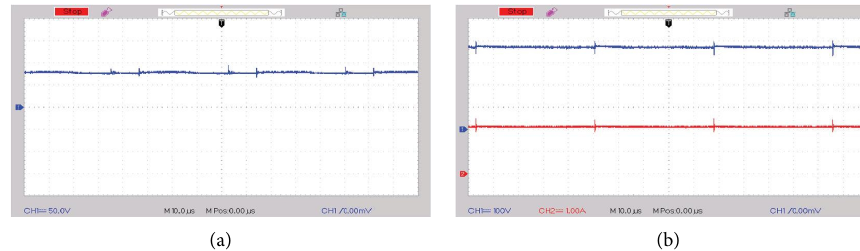
Figure 31: (a) Capacitor voltage. (b) Voltage and current of the load.